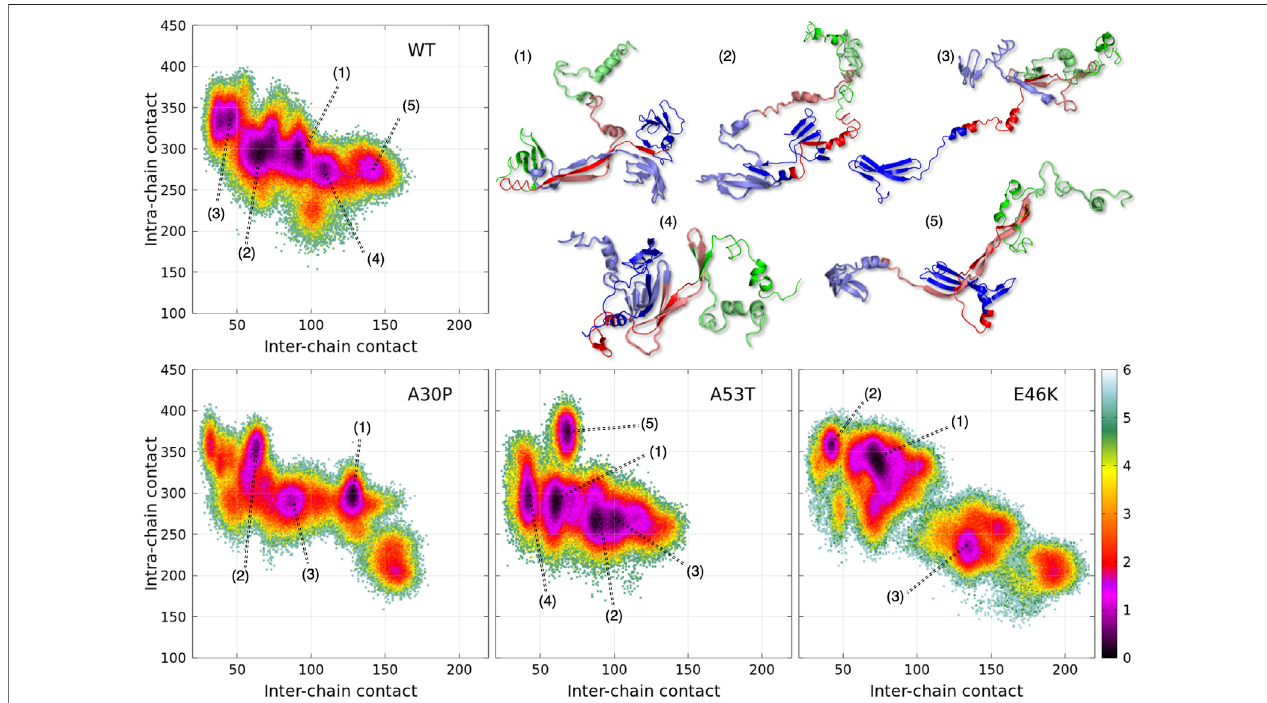
] computed from the 2D probability density function P of the number of inter-chain ( n FIGURE 1 | Color maps of -ln [ P ( n inter , n intra ) inter ) and intra-chain ( n intra ) contacts P max betweentheresiduesof α -synforthecompleteensembleofdimersfoundinmoleculardynamicstrajectoriesat300and310 KoftheWTandvariants.Ineachmap, P max is the maximum value of the probability of the map. The local minima within one unit from the global minimum of each map are numbered. Examples of 3D structures associated with each local minimum of the WT are represented with the N-terminus in blue, NAC in red, and the C-term in green. The light and dark colors differentiate the structure of the two monomers within the dimers.